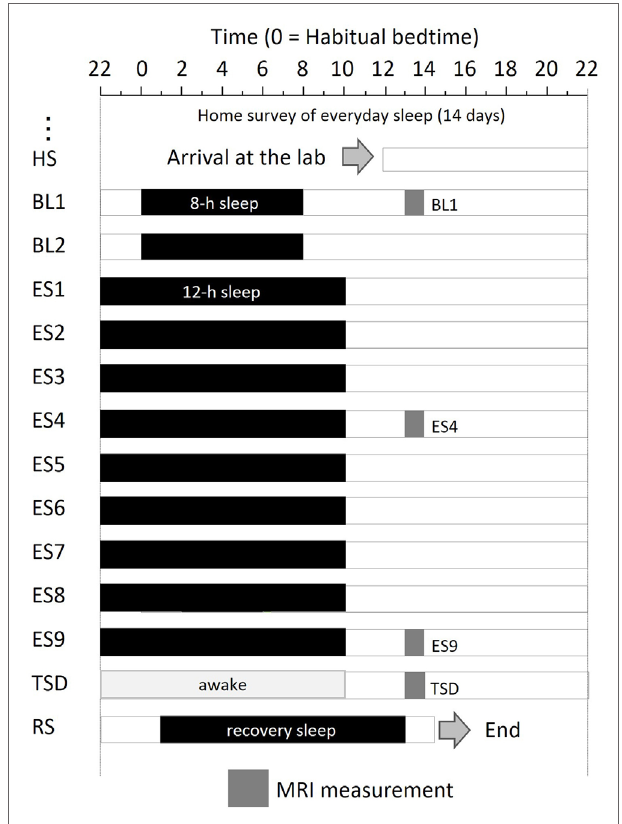
FigUre 1 | Experimental protocol. Subjects were enrolled in a 14-day and 13-night study, with 8 h of sleep on the first 2 days, 12 h of sleep for the next 9 days, a night of total sleep deprivation, and a night of recovery sleep. MRI was performed at 9 h after the midpoint of sleep on day 1 (BL1), sleep on day 6 (ES4), sleep on day 11 (ES9), and the TSD period on day 12. Subjects underwent overnight PSG measurements throughout the study period. Black bars, sleep time; HS, habitual sleep at home; BL1, baseline day 1; ES4, extended sleep day 4; ES9, extended sleep day 9; TSD, total sleep deprivation; RS, recovery